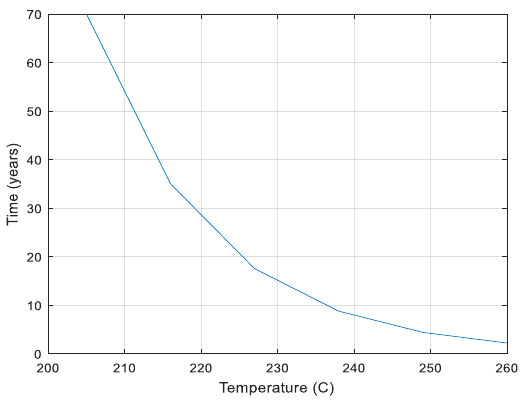
Figure 23. Aging graph of windings insulation.